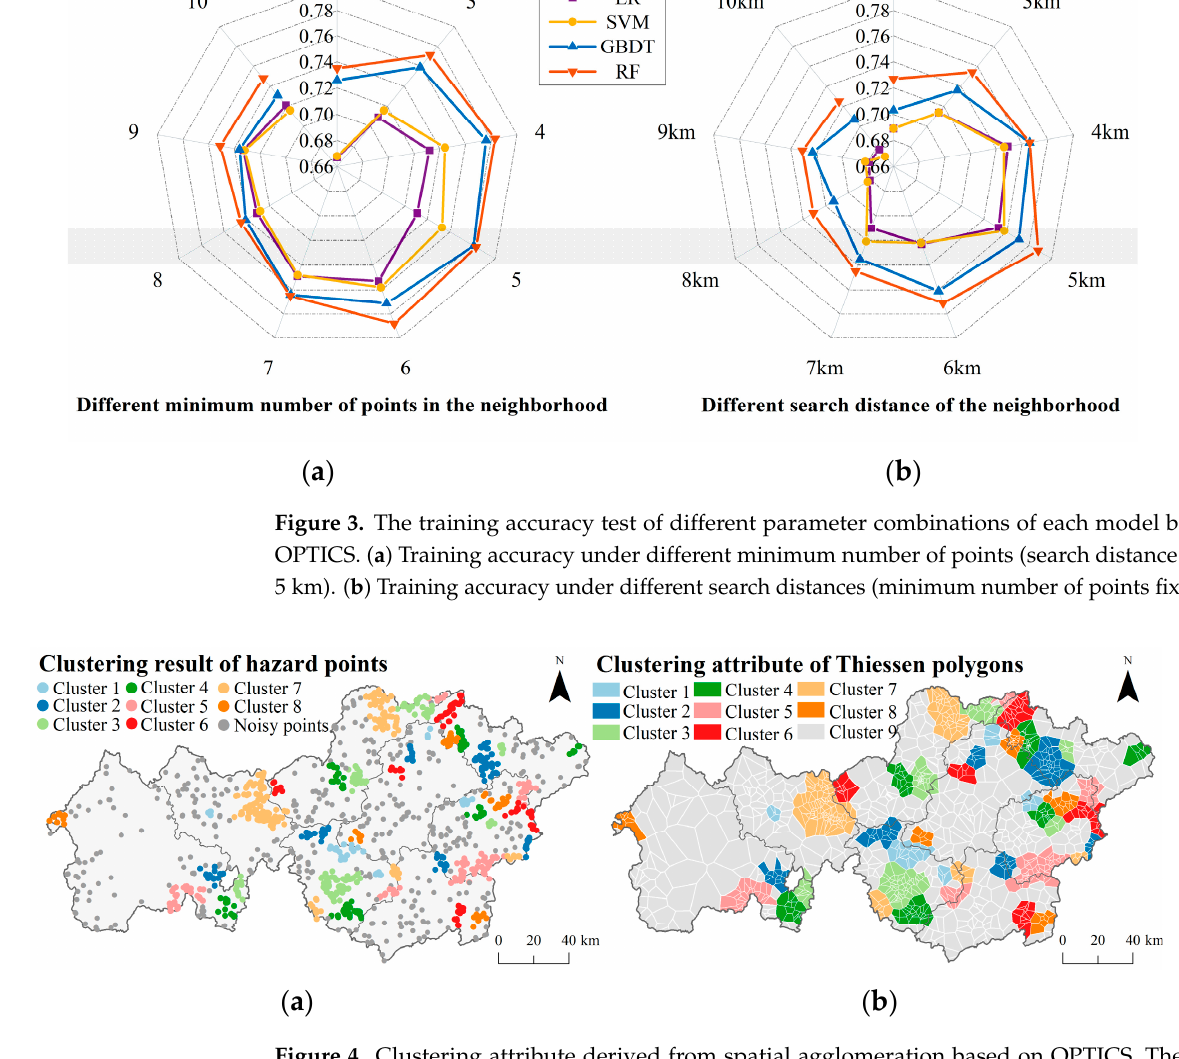
Figure 4. Clustering attribute derived from spatial agglomeration based on OPTICS. The results here correspond to the combination of 6 as the minimum number of points and 5 km as the search distance. ( a ) Clustering results of hazard points based on OPTICS. ( b ) Clustering attribute of Thiessen polygons based on point clustering results.